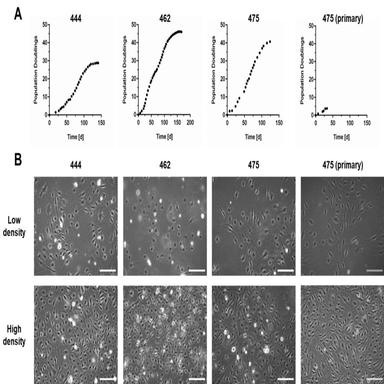
Lentiviral transduction with upcyte® genes enables transient expansion of human liver sinusoidal endothelial cells (LSECs). (A) Cumulated PDs in transduced or primary LSECs during long-term culture. Transduced LSECs (donors 444, 462 and 475) or primary cells (donor 475) were cultured until growth arrest occurred. (B) Representative phase contrast images at low or high density. Bar - 20 µm.